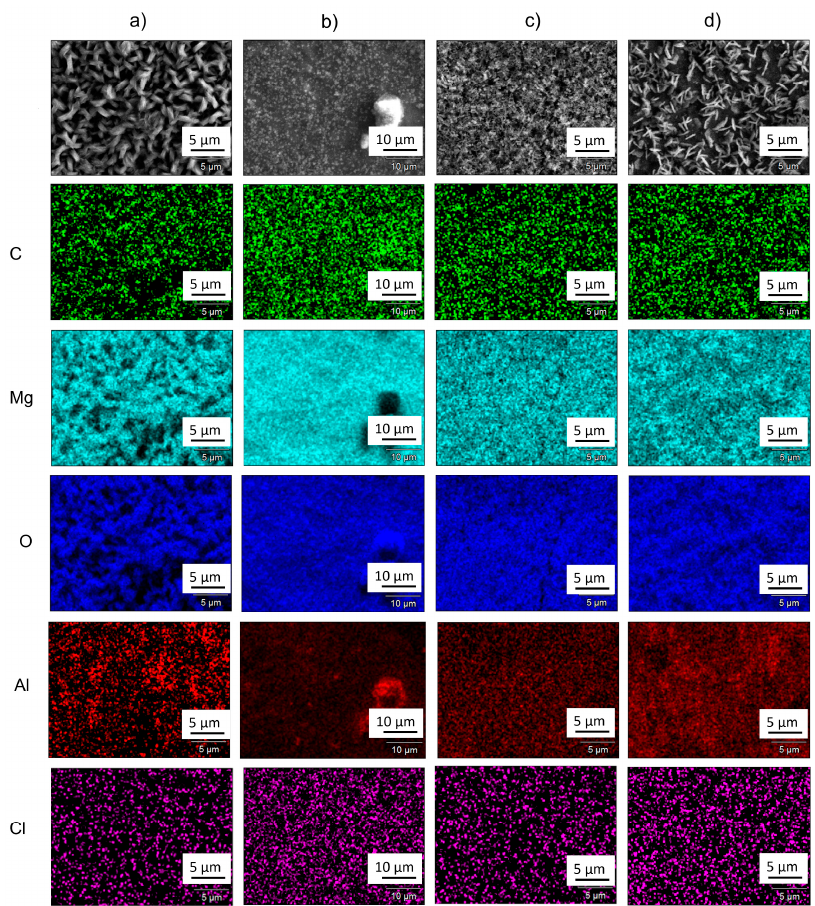
Figure 8. EDS mapping of surface of ( a ) E1024, ( b ) E1124, ( c ) A1024, and ( d ) A1124 after immersion in 0.1 M NaCl solution for 7 days.